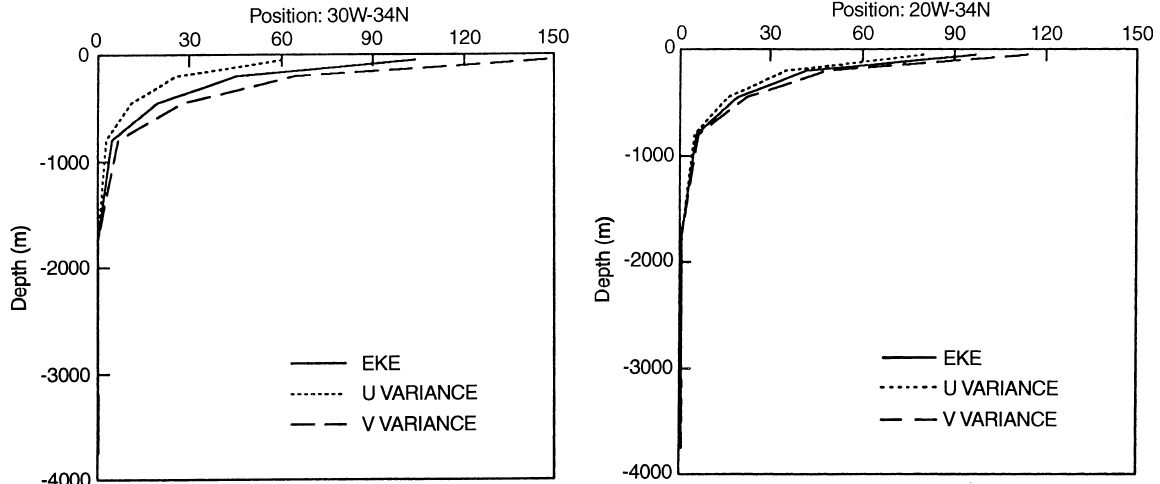
Fig. 13. Vertical profiles of the eddy kinetic energy, the variance of U and the variance of V computed over the two years of simulation at 30 (cid:176) W, 34 (cid:176) N and at 20 (cid:176) W, 34 (cid:176) N